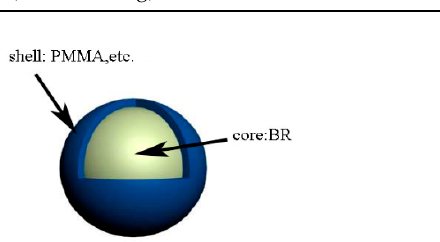
Figure 1. Structure of CSR particle.